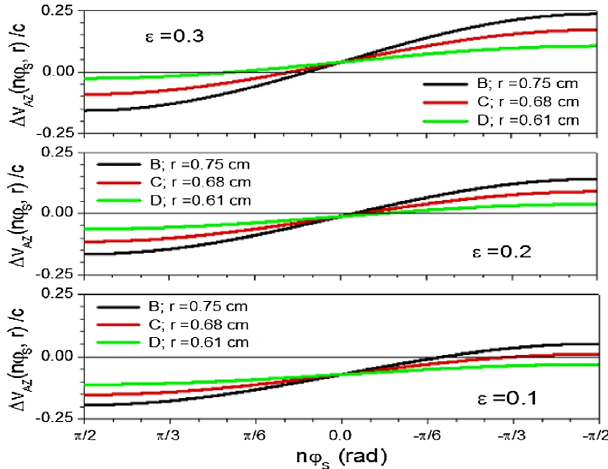
FIG. 3. Azimuthal velocities of the drifting charge and the synchronous wave difference in units of c at various r , and ε vs n φ S